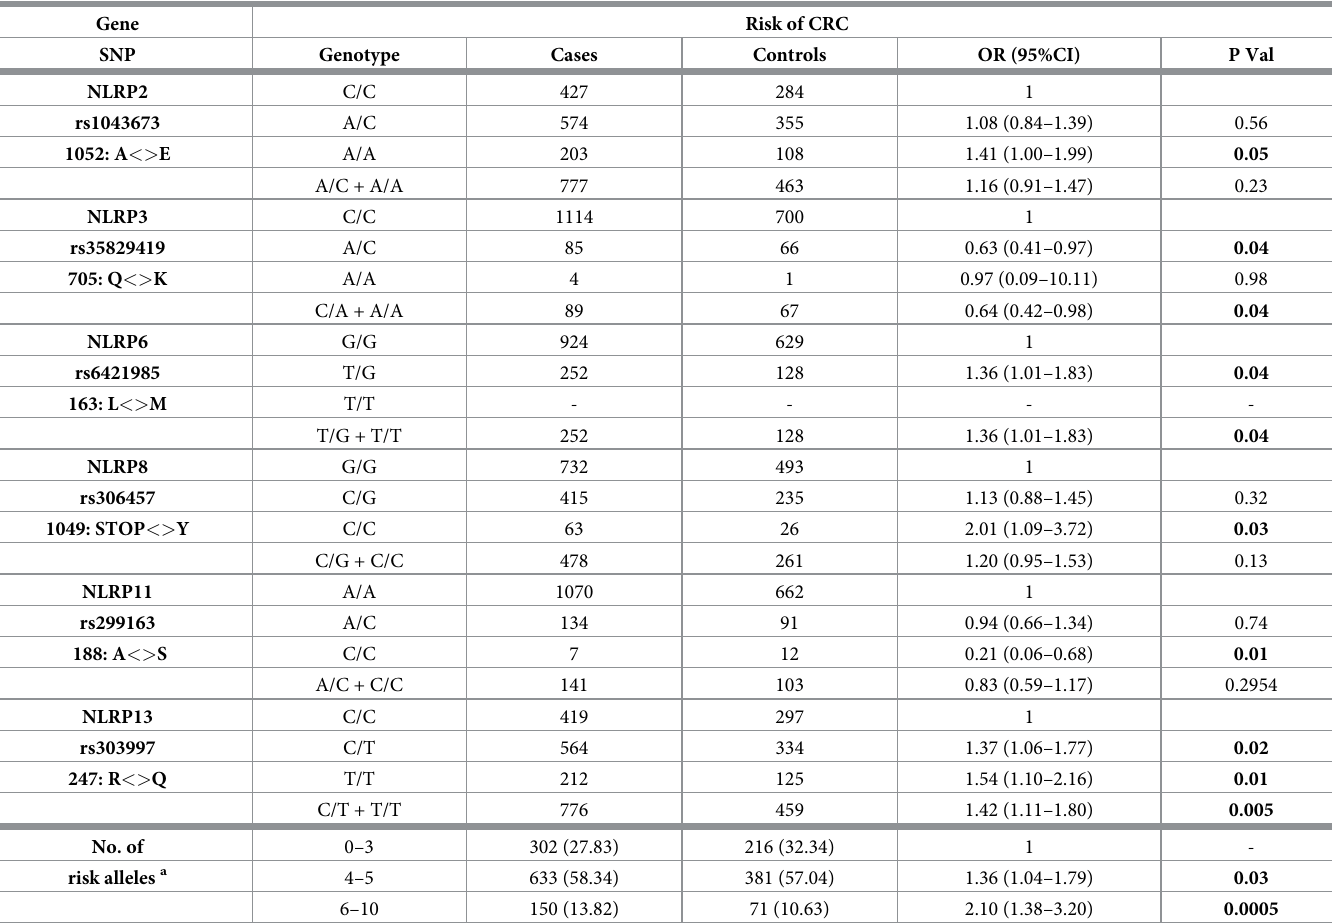
Table 1. CRC risk: genotype distribution of SNPs analyzed in the Czech case-control population for SNPs with p (cid:20) 0.05. Amino acid changes are given as <> with the amino acid position indicated. Data adjusted for age at diagnosis and sex. Nominal significance at p (cid:20) 0.05; significance level corrected for multiple testing (39 geno- typed SNPs) at p (cid:20)